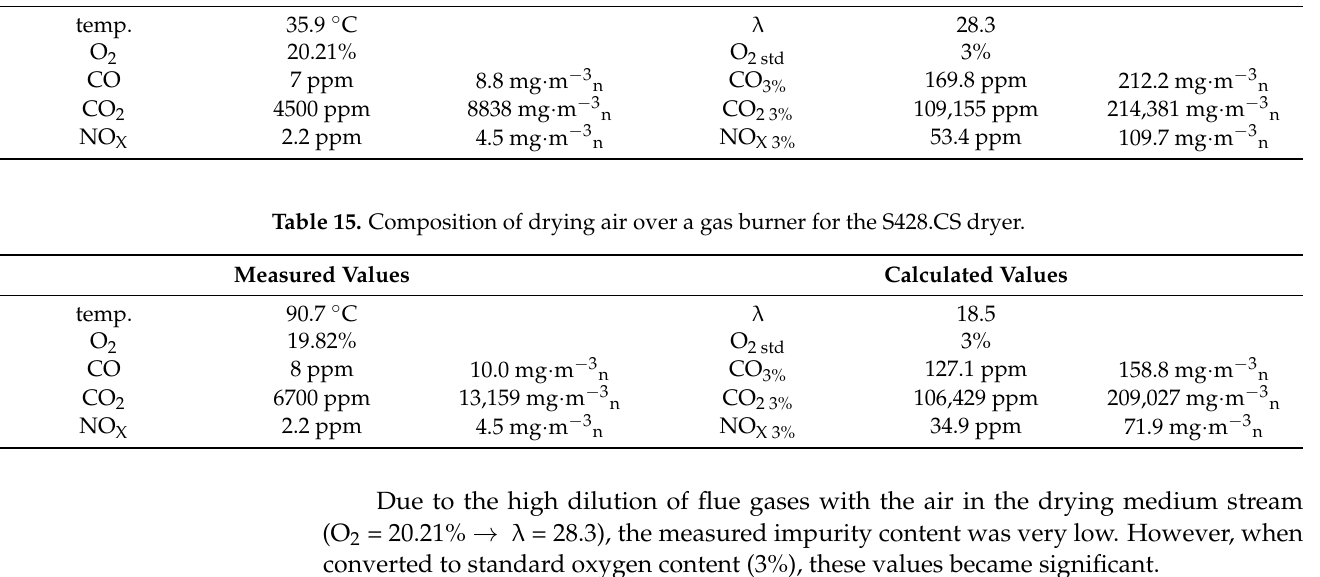
Table 14. Composition of waste gases for the S428.CS dryer. Measured Values Calculated Values temp.